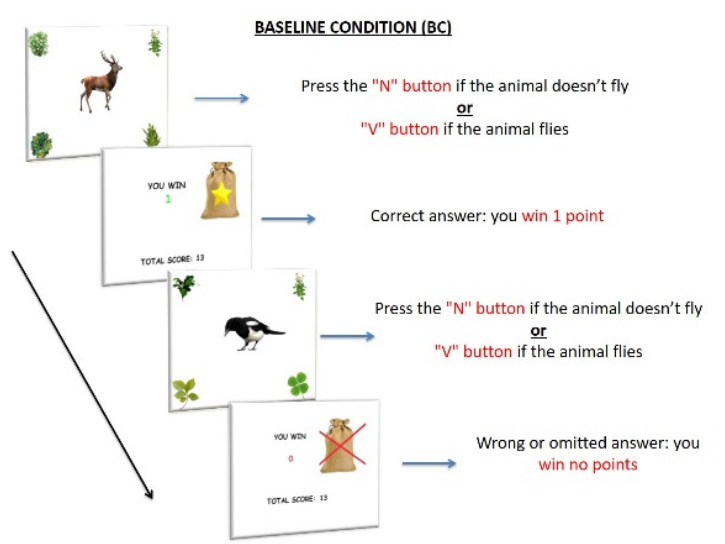
Figure 1. Procedure of Baseline condition (BC). The items consisted of 108 images of an animal located at the center of the screen; images of plants were located at the four corners of the screen. Participants had to press the “N” button when the image of a non-flying animal appeared on the screen and the “V” button when the image of a flying animal appeared on the screen (semantic decision task). Each stimulus appeared for 2 s. Participants received 1 RP for every correct answer and no RP for any wrong or omitted answer.